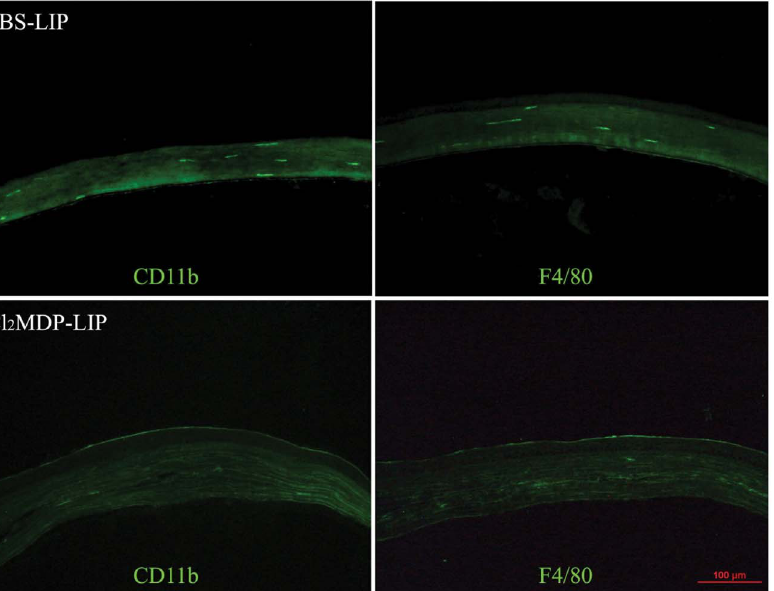
Figure 1. Sub-conjunctival Cl 2 MDP-LIP injection depleted corneal resident macrophages. Immunofluorescence staining of cornea after 2 days of liposome injection showed a few F4/80 + CD11b + macrophages in the central cornea of mice injected with PBS-LIP, while there was no specific staining in mice injected with clodronate liposomes.